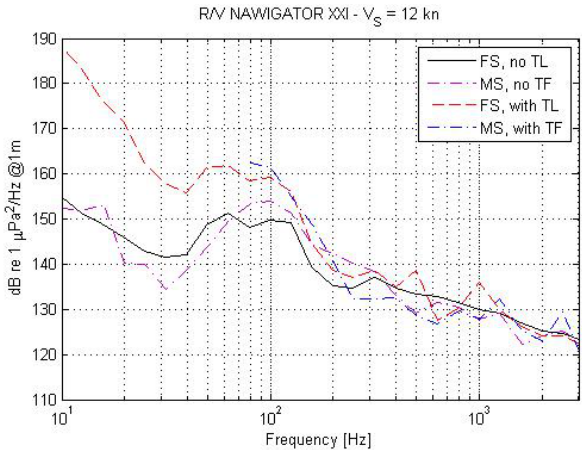
Figure 23: Comparison between full scale underwater noise and model scale propeller noise measurements – application of transfer function in model scale and transmission losses in full